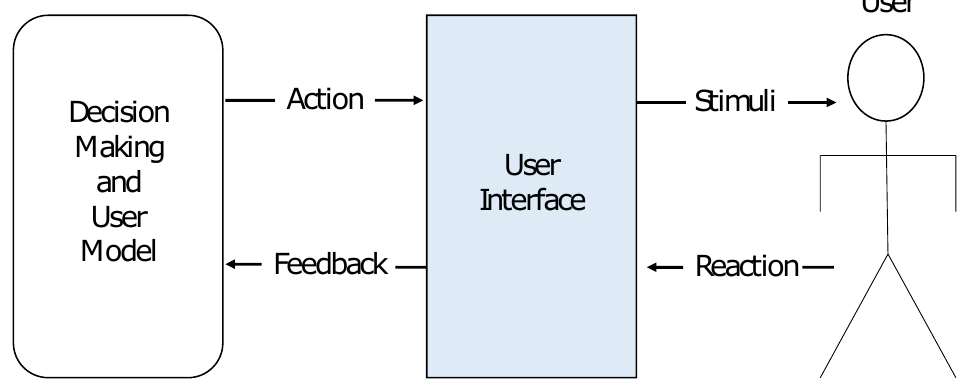
Figure 5. Overview of a generic user-adaptive system, which includes a user interface layer and a decision-making